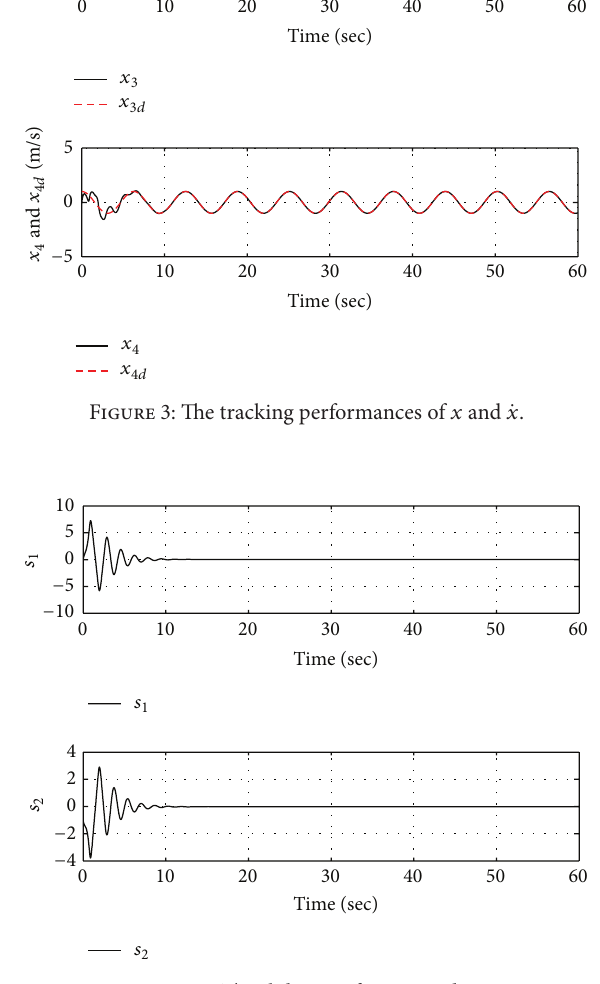
Figure 4: The sliding surfaces 𝑠 1 and 𝑠 2